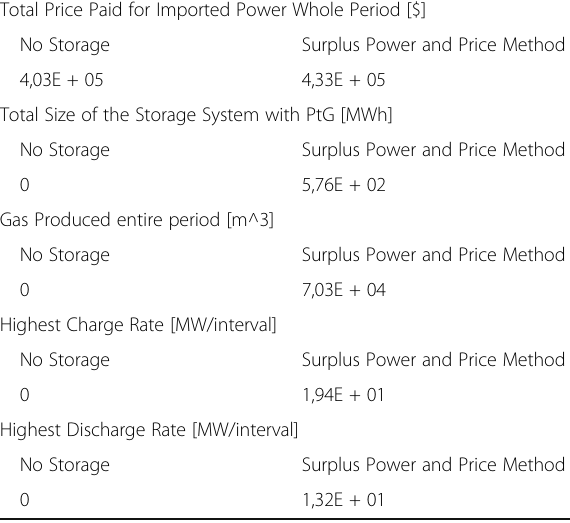
Table 2 Sizing ESS with